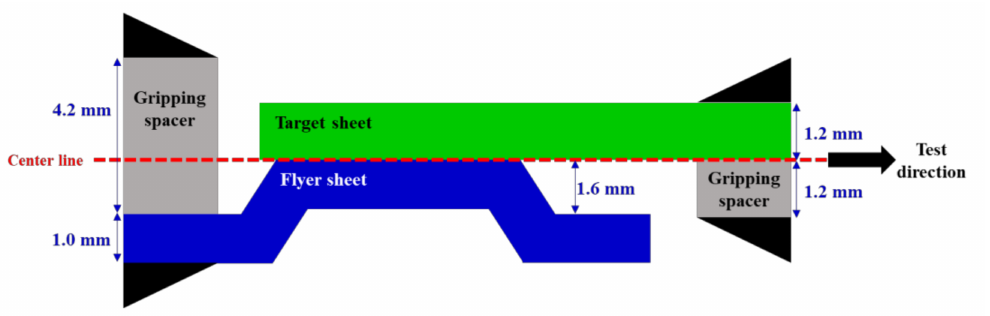
Figure 6. Schematic design of the lap shear